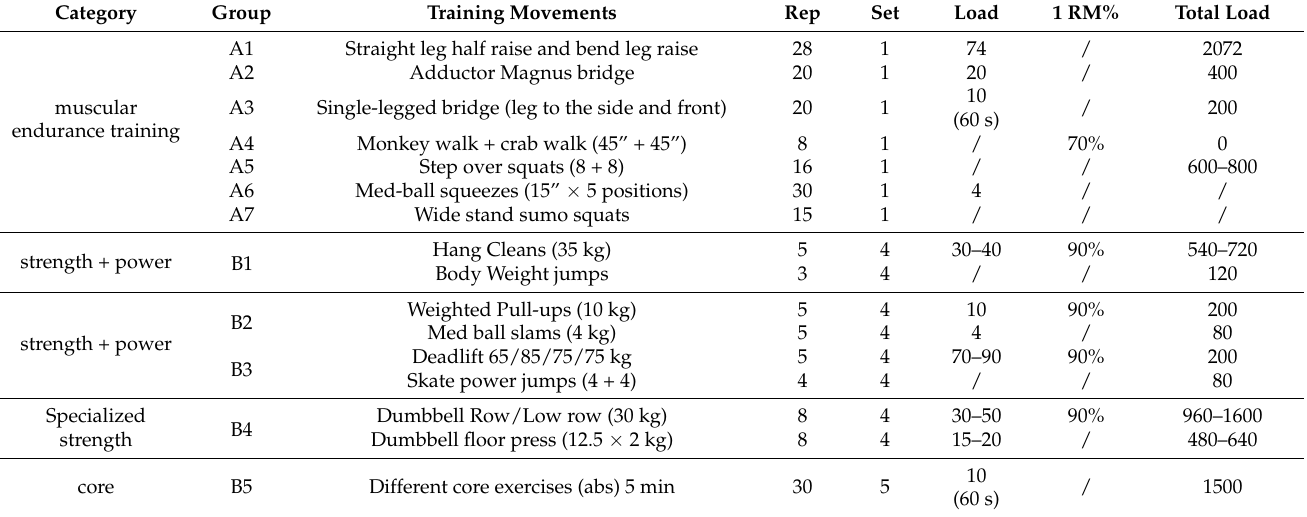
Table 3. Strength training content and load for cross-country